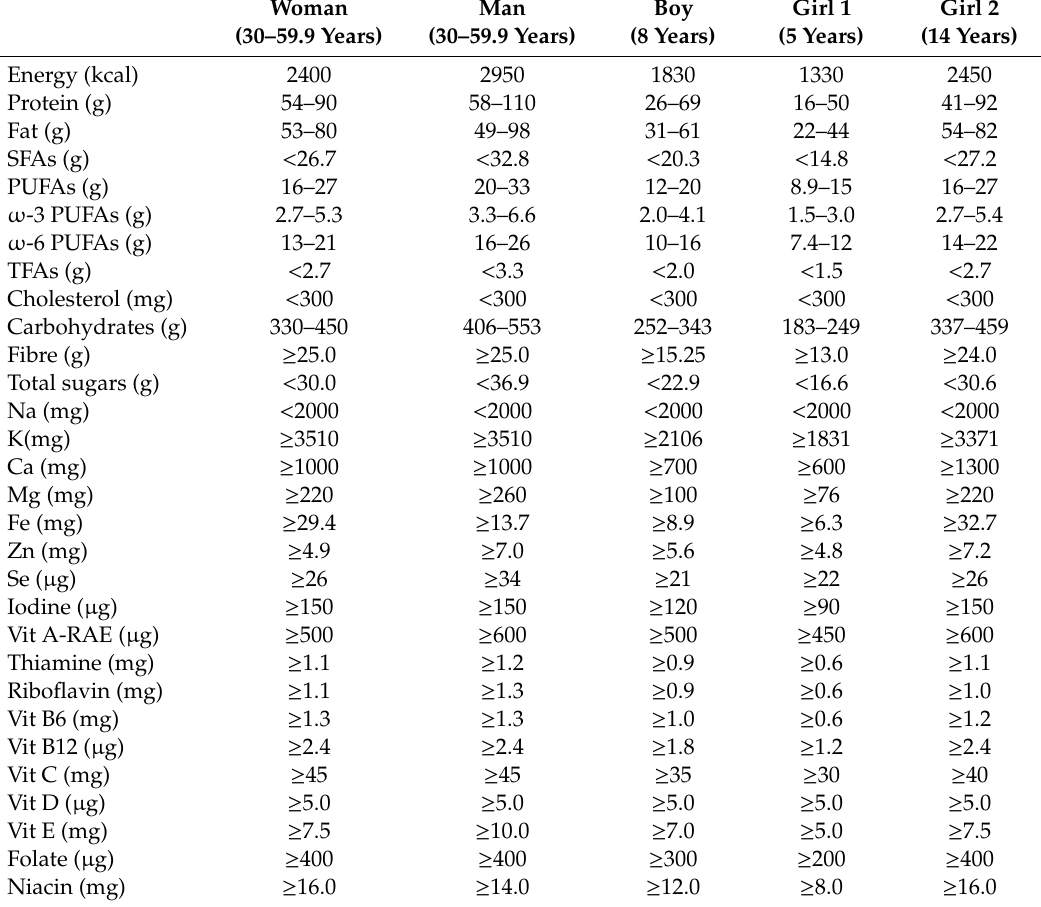
Table 1. Energy and nutrient intake recommendations applied during linear programming. The estimated energy requirement (EER) reference value is based on a physical activity level of 1.75 for both woman and man. The nutrient contents of all calculated food baskets lie within the indicated ranges of AMDRs and RNIs